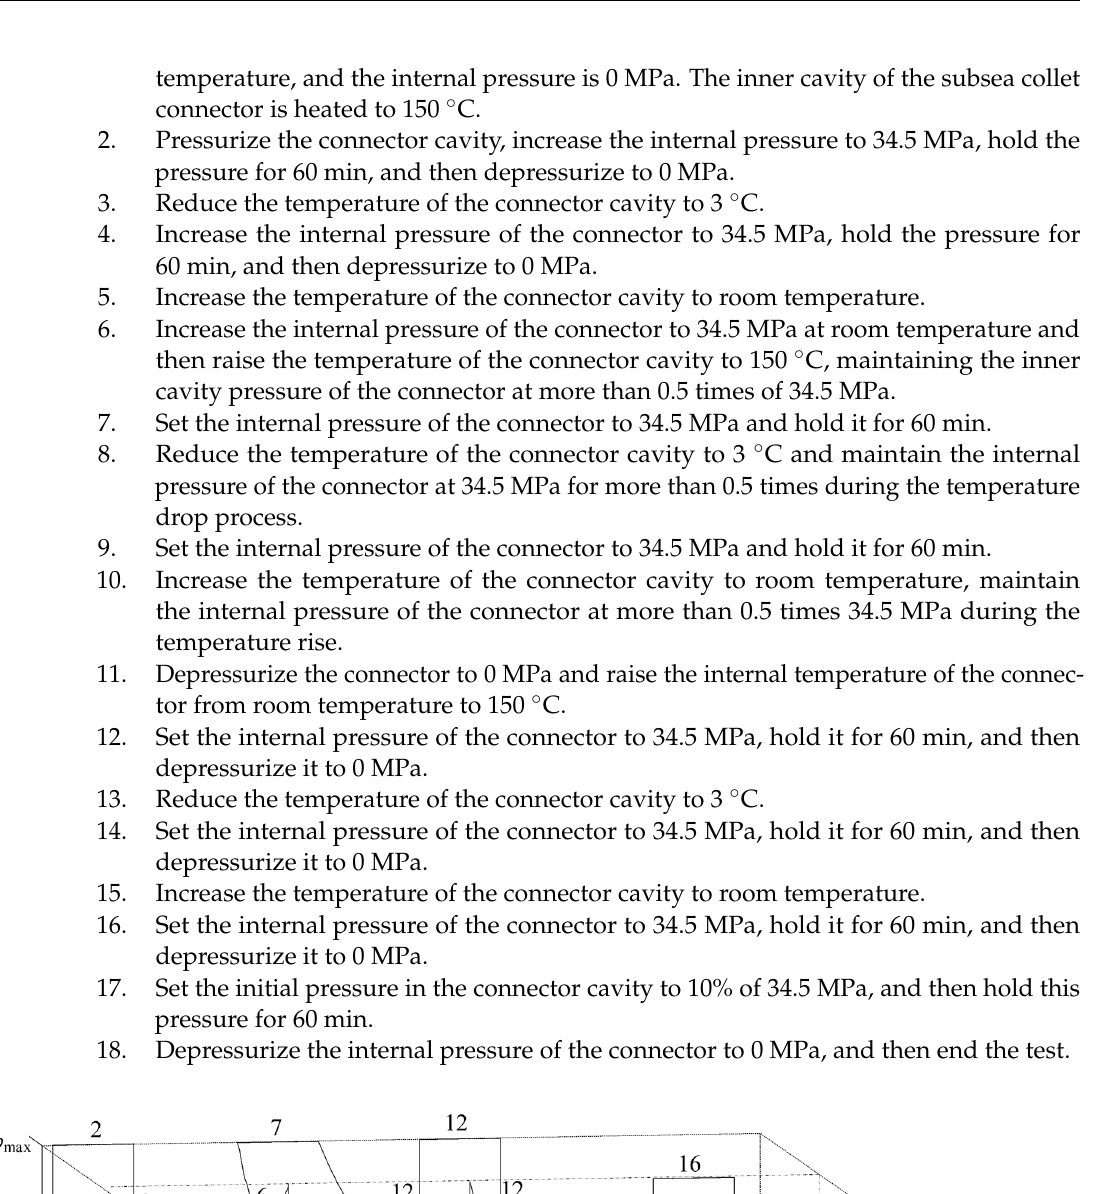
Figure 11. Device of temperature cycle test. ( a ) Temperature cycle test box; ( b ) connector and con- nection line; ( c ) liquid nitrogen container; ( d ) console station.